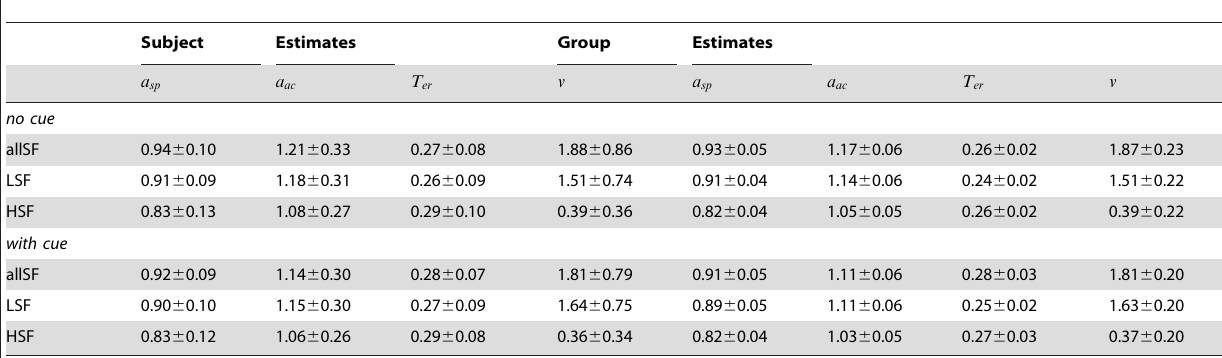
Table 4. Estimated HDDM parameters during